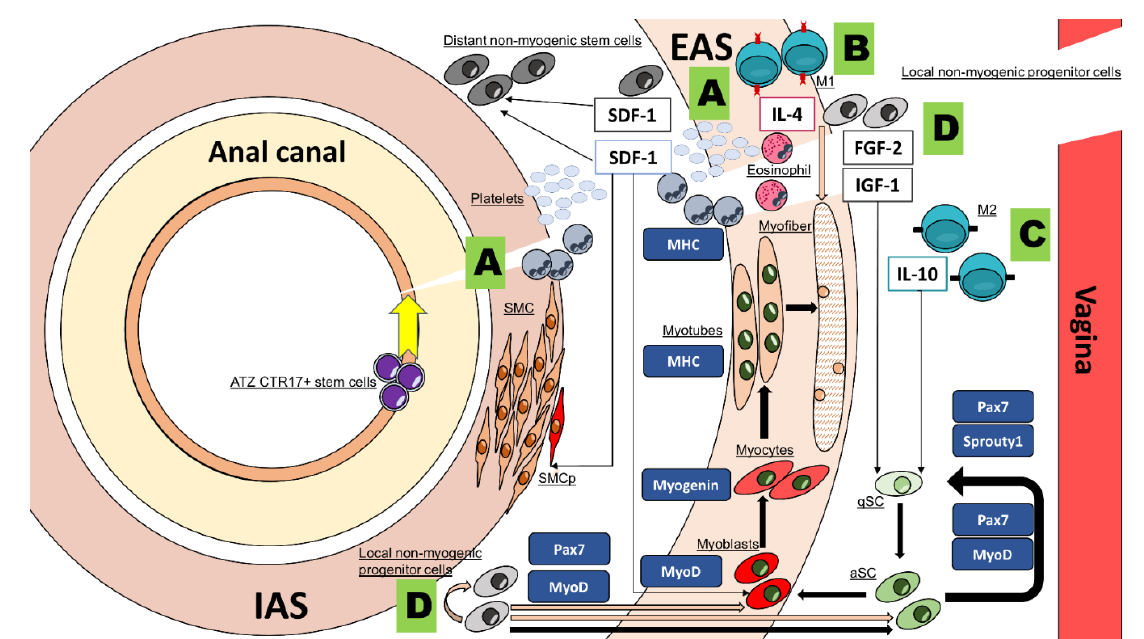
Figure 1. Schematic representation of events occurring after delivery-related acute anal sphincters injury [20,22]. ( A ) The tear will induce a phase of inflammation where polymorphonuclear cells are attracted in the first hour and are responsible to maintain the function of macrophages that will arrive later. At the same time, platelets recruitment following the rupture of small vessels induces the releasee of SDF-1 following their degranulation. SDF-1 is primordial for anal sphincter regeneration and acts by attracting non-resident progenitor cells, myoblasts and smooth-muscle progenitors to the wound and by promoting the survival, migration and proliferation of these cells. ( B ) Macrophages of M1 (CD68 + ) polarity arrives after the polymorphonuclear cells and largely contribute to the acute inflammation phase. ( C ) During the healing phase, activated satellite cells contribute to new muscle formation (black arrows) and each step is characterized by a specific hallmark protein expression (blue boxes). Then, macrophage polarity switches to M2 (CD163 + ) and they produce cytokines such as Il-10 helping proliferation and differentiation of satellite cells. ( D ) During the healing phase, different kinds of non-myogenic local progenitor cells are activated, and some of them, like the fibro-adipogenic progenitors, are conditioned by the presence of IL-4 secreted by eosinophils, with this pathway being necessary for skeletal muscle regeneration. Non-myogenic local progenitor cells interplay indirectly by the production of cytokines like FGF-2 and IGF-1 but can also fuse (camel arrows) with other non-myogenic local progenitor cells, satellite cells, myoblasts or even myofibers, inducing hypertrophy. Finally, in case of damage to the rectal wall mucosa, local stem cells of the anal transition zone contribute to the reparation of the rectum and anal transition zone mucosa. qSC: Quiescent satellite cell, aSC: Activated satellite cell,